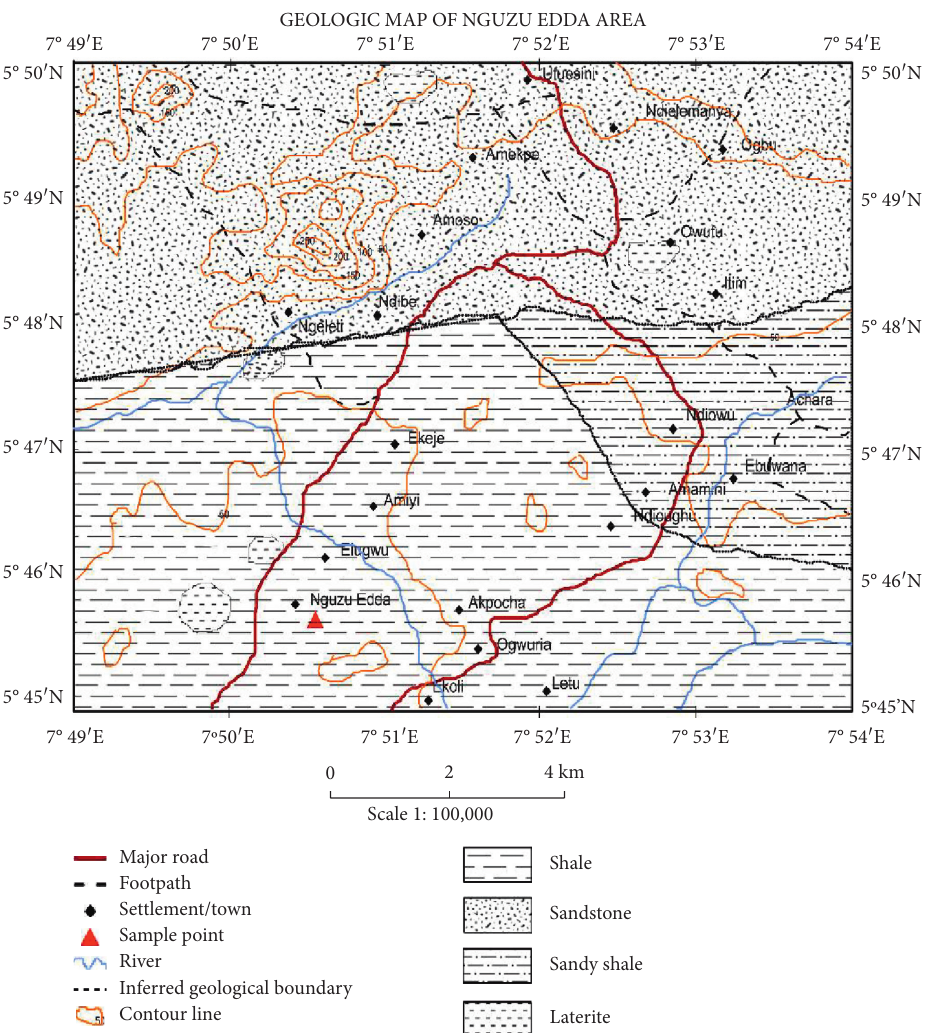
Figure 2: Geological map of the study